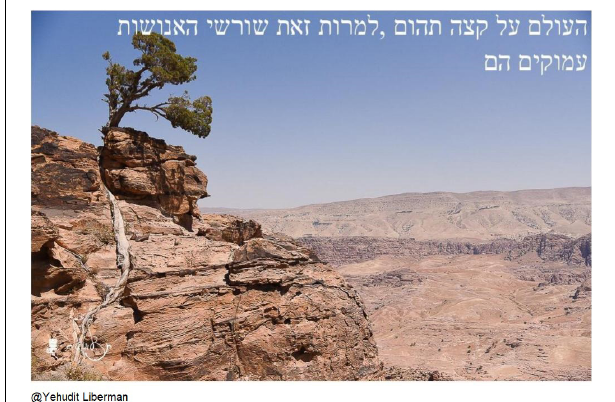
FIGURE 8 | Rivka’s chosen photograph and title: “The world is on the edge of an abyss, yet the roots of humanity are deep.”